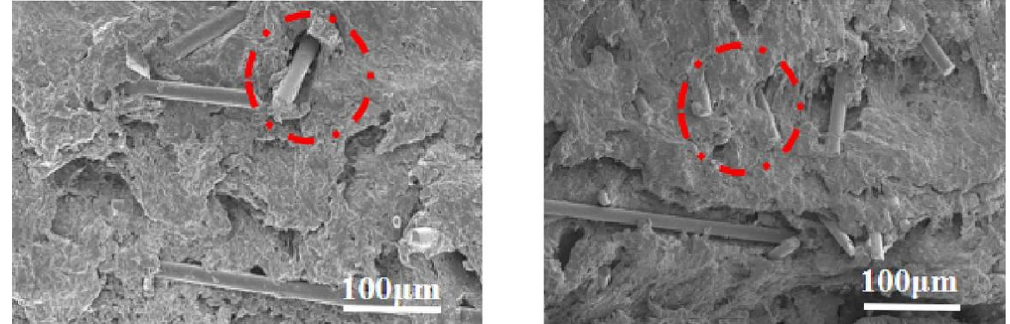
Figure 9. The SEM photos of EVA/MH-PBF15 and EVA/MH-MBF15 composites tensile fracture topography.